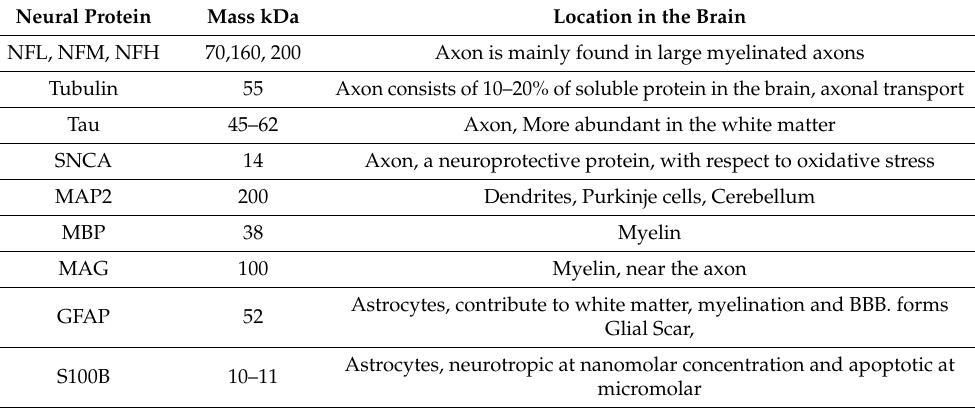
Table 2. Glial proteins (Mass and